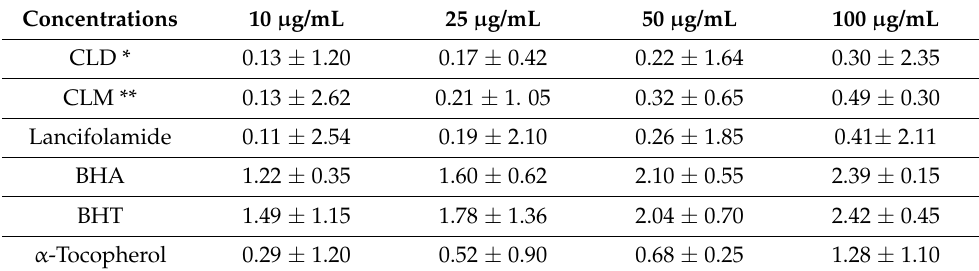
Table 4. CUPRAC assay results. Mean ± SD (n = 3).